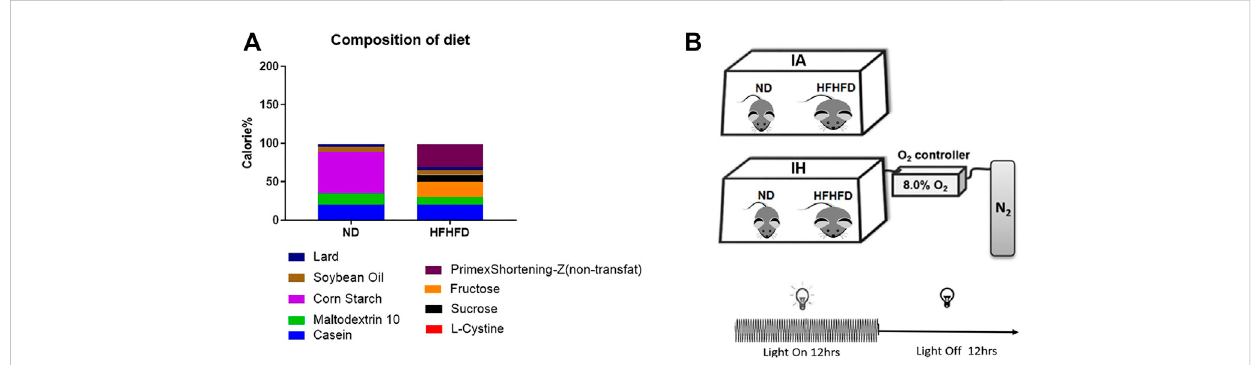
FIGURE 1 Diet and treatment. (A) Food composition and calorie ratio of the individual components were provided in ND and HFHFD. (B) The IH chamber was monitored with an automated gas controller and designed for mimicking different levels of hypoxia exposure by regulating the ratio of the gaseous